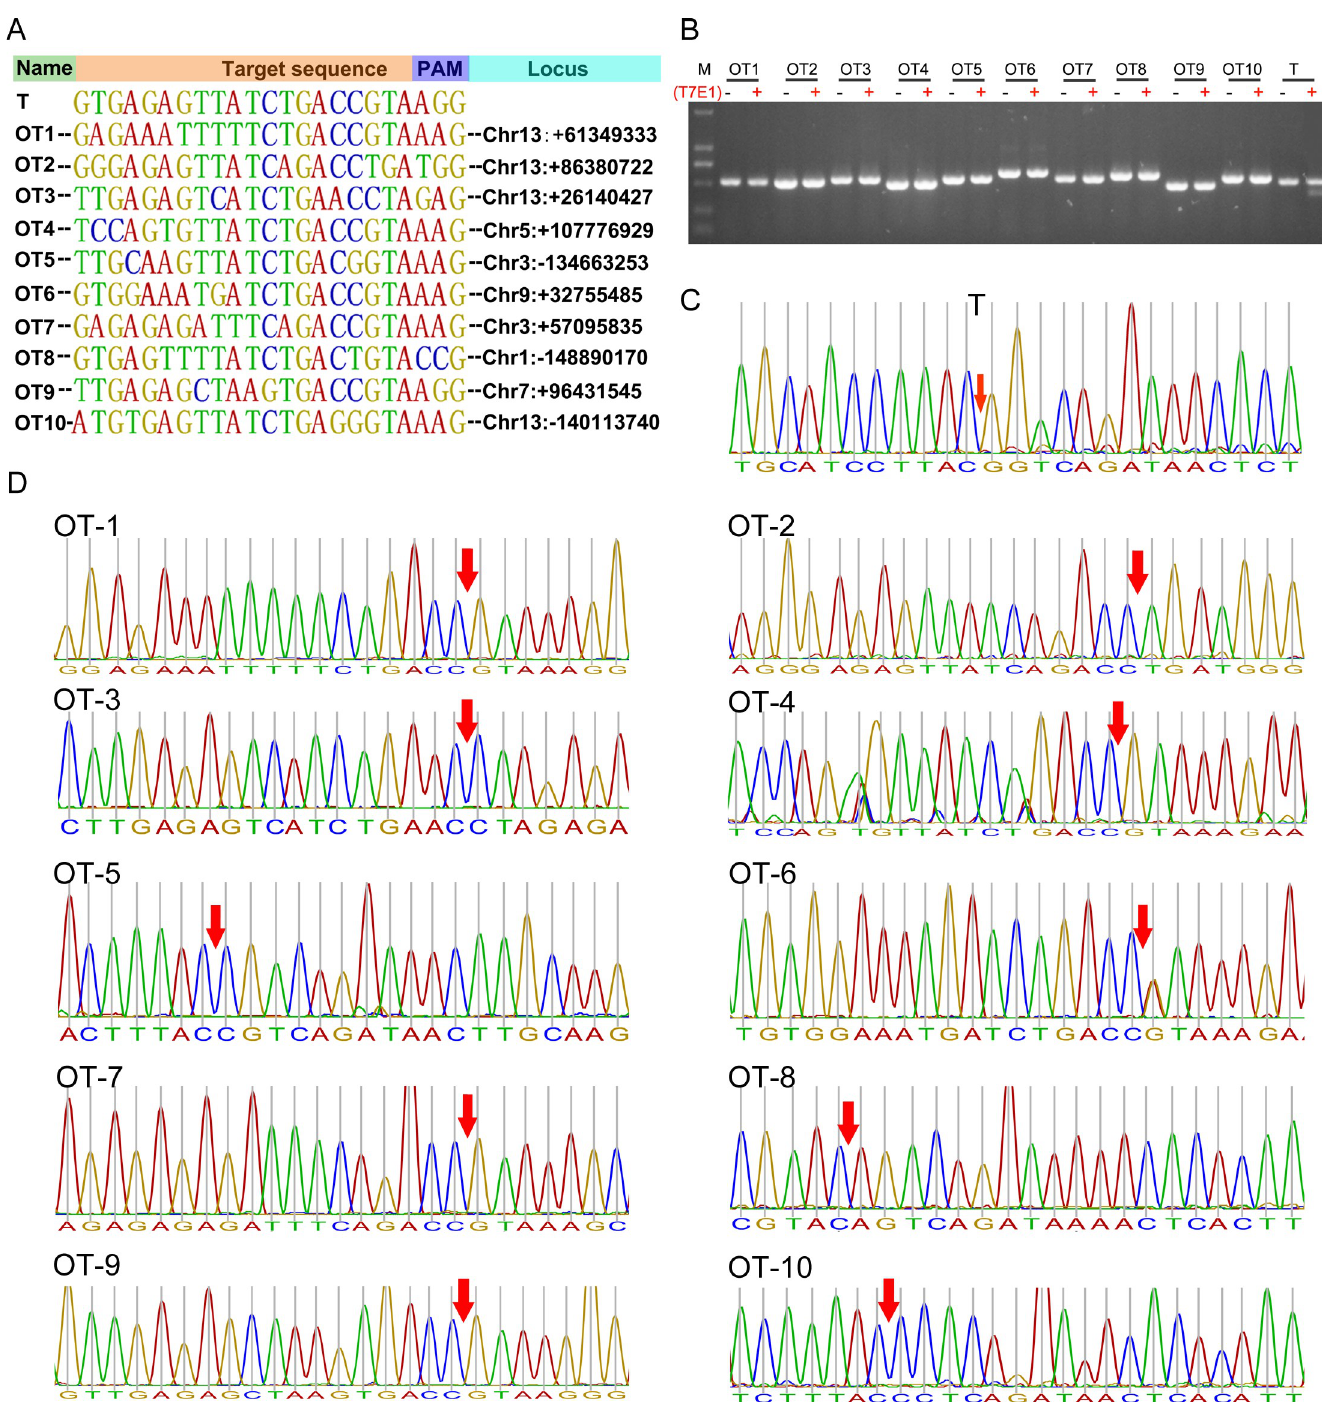
Fig 3. Off-target site analysis. ( A ) The target site (T) and ten predicted off-target sites (OT) for sgRNA91/Cas9. OT1~OT10 represents 10 potential off-target sites, and T represents target site. ( B ) T7E1 cleavage assays for the target site and the ten potential off-target sites; M, DL2000; ( C ) Sanger sequencing analyses of PCR amplicons that spanning the target sites. The cleavage sites are labeled with red arrow. ( D ) Sanger sequencing analyses of PCR amplicons that spanning the potential off-target sites. The potential cleavage sites are labeled with red arrow.